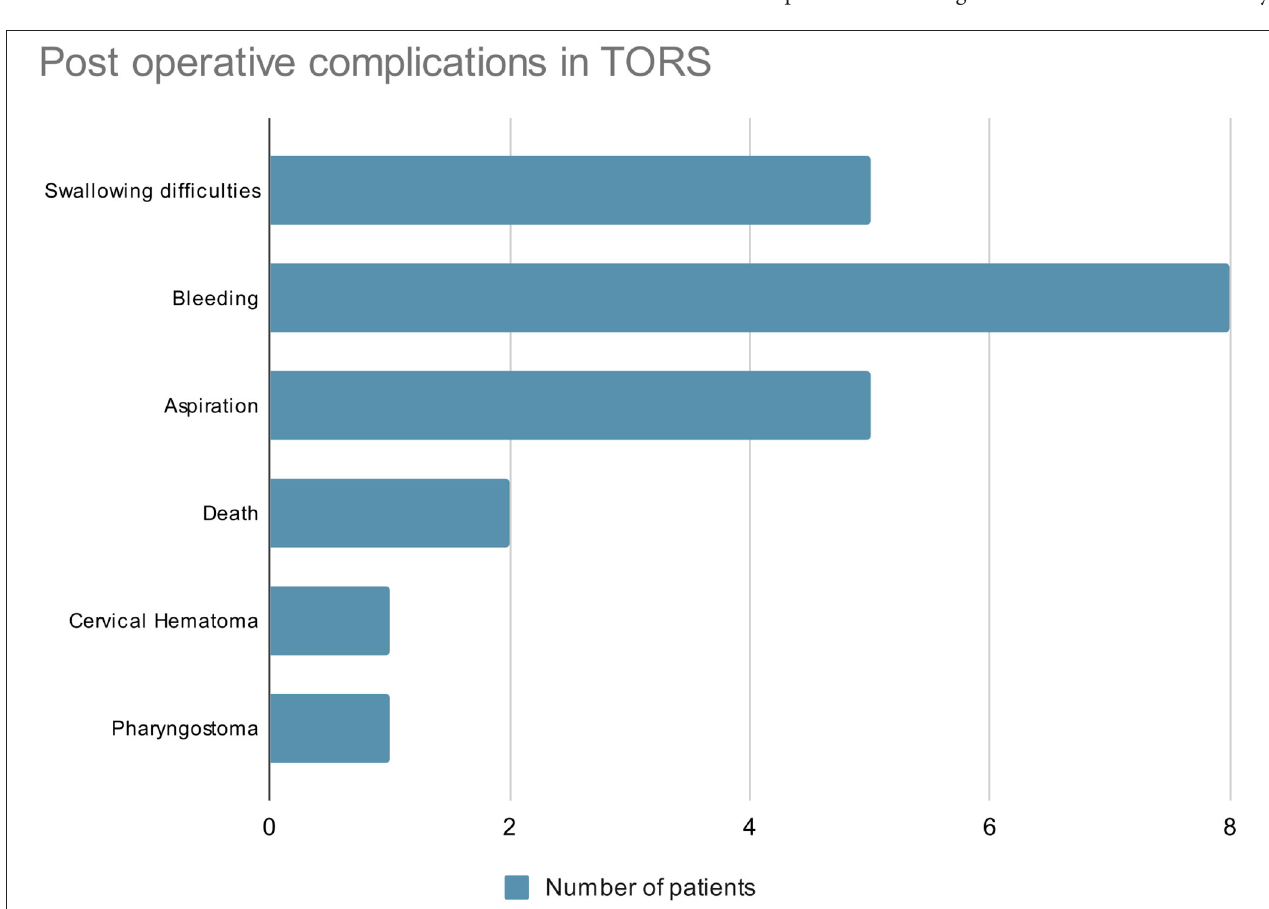
FIGURE 3 | Post-operative complications in